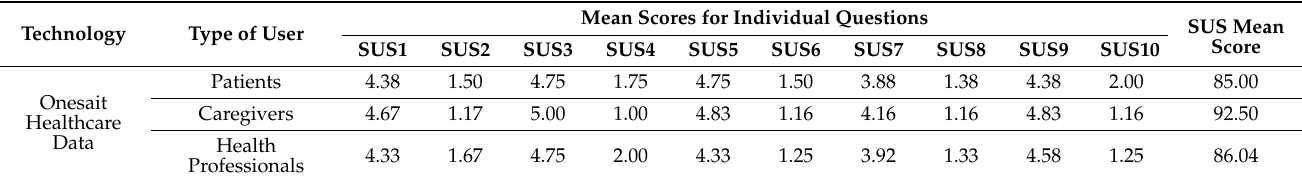
Table 13. SUS mean scores for Onesait Healthcare Data with the integrated technologies during the pre-validation phase